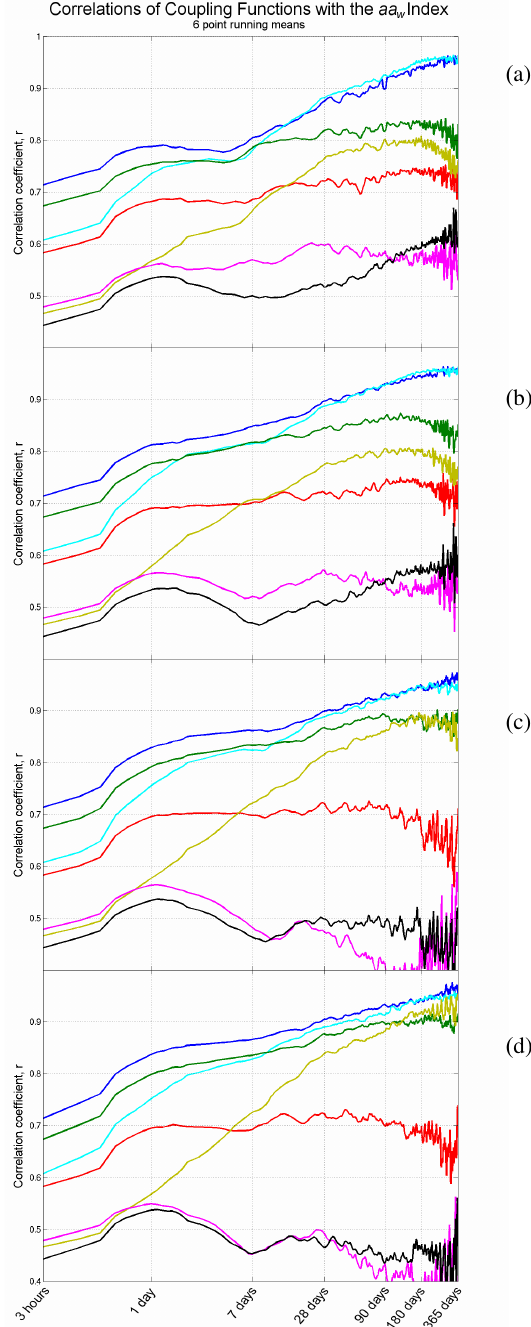
Fig. 12. The same as Fig. 10, but for the aa w rather than the am w